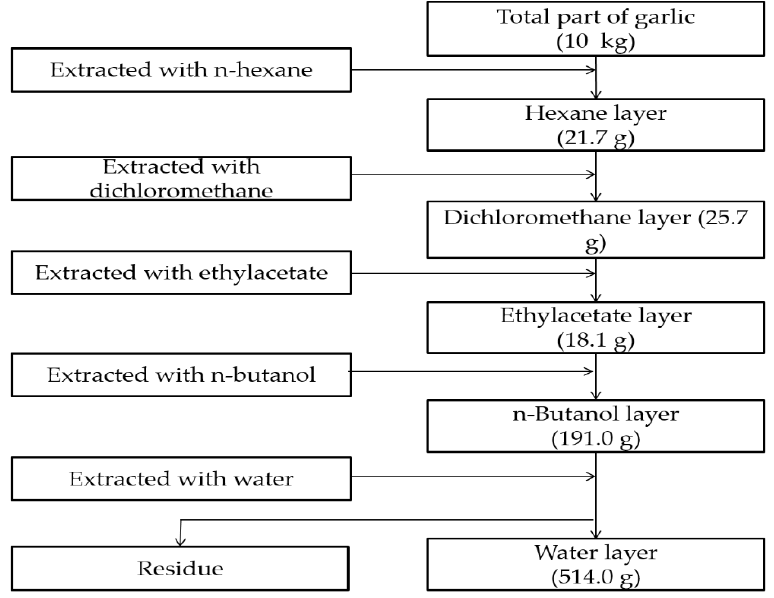
Figure 9. Fraction extraction procedure. The garlic was extracted using n-hexane, followed by dichloromethane, ethylacetate, n-butanol, and water.